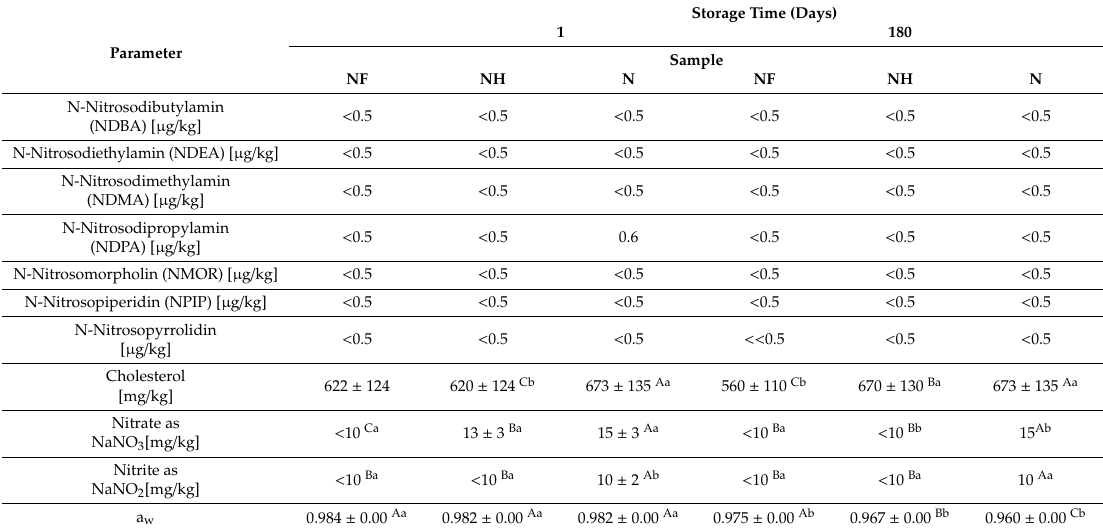
Storage Time (Days) 1